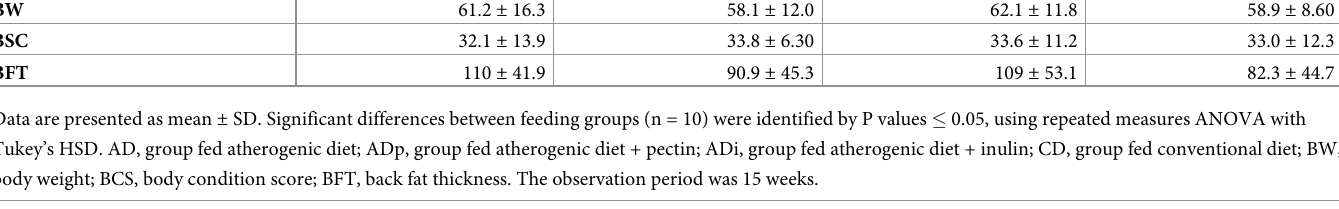
BW, BCS and BFT are provided in a supplementary table ( S1 Table) .